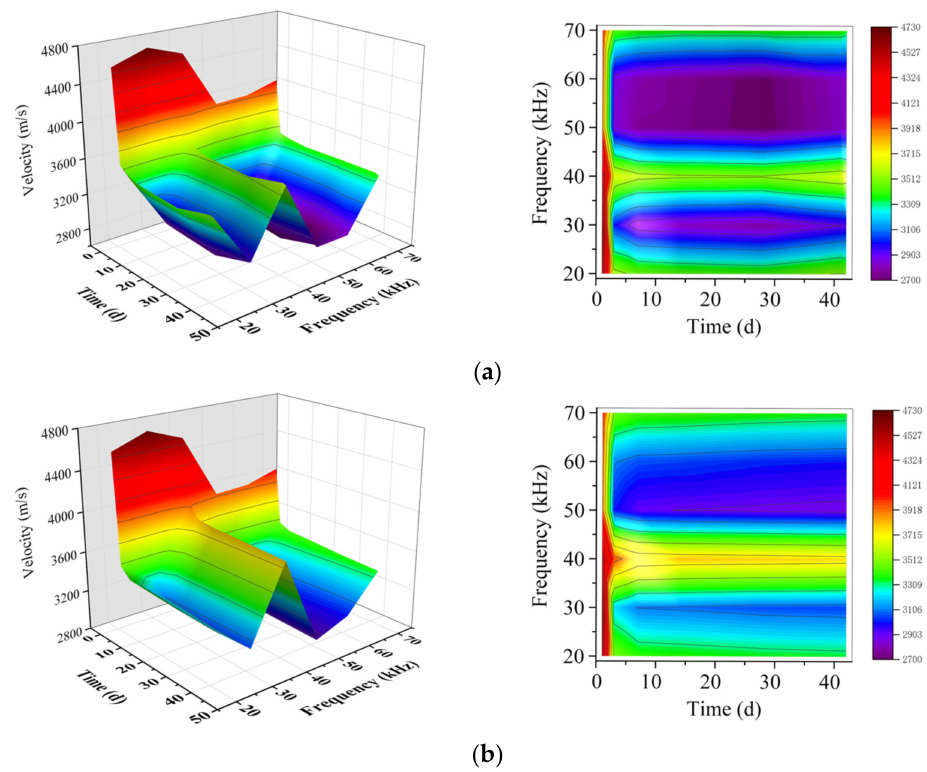
Figure 7. Velocities at different guided wave frequencies; ( a ) sample A; ( b ) sample